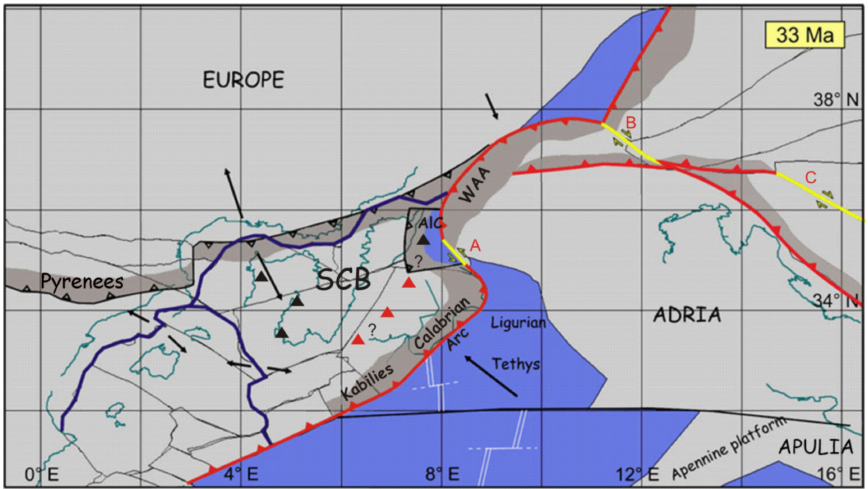
Figure 2. Plate reconstruction of the western Mediterranean region at 33 Ma. The distribution of the continental lithosphere is shown in ( gray ). Present-day coastlines are shown for reference. ( Black ) arrows represent direction and magnitude of relative motion. Strike–slip faults are shown in ( yellow ), labeled A, B, C. ( Red lines ) are convergent boundaries. Blue lines are divergent boundaries. ( White lines ) represent extinct spreading centers. ( Red triangles ) are volcanoes associated to the Tethys subduction; black triangles are volcanoes probably associated with the pyrenaic subduction. AlC: Alpine Corsica; SCB: Sardinian-Corsican block; WAA: Western Alpine Arc; modified after [18].